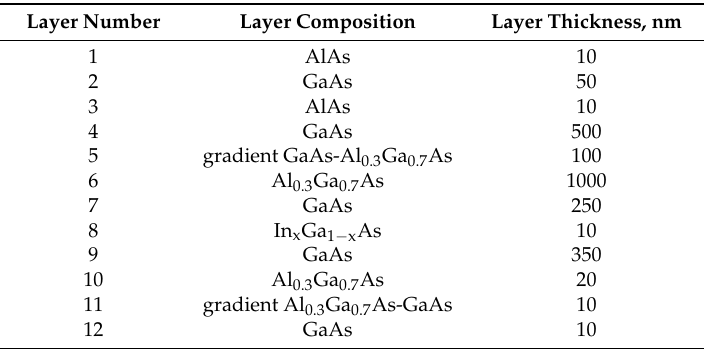
Table 2. Parameters of laser structures G and